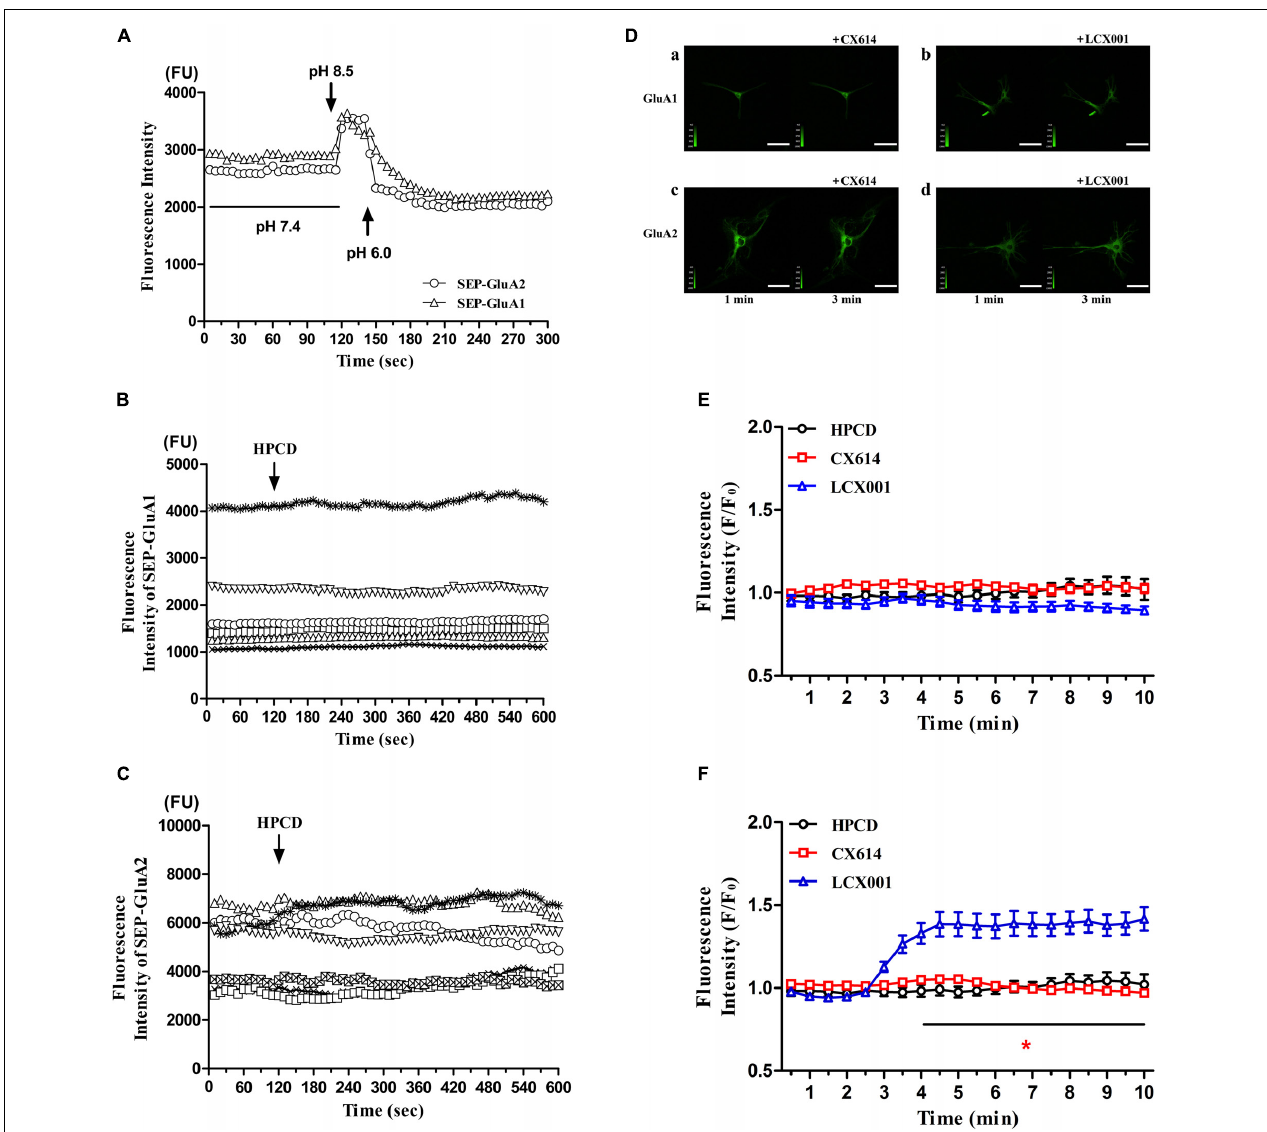
FIGURE 5 | LCX001 increased surface expression of GluA2-containing AMPARs. (A) Time courses of SEP-GluA1 and SEP-GluA2 fluorescence in primary medulla oblongata neurons after exposure to extracellular alkali or acidic solutions. (B,C) SEP-GluA1 or SEP-GluA2 fluorescence time course after vehicle (20% HPCD) treatment at the time point of 2 min. The application of vehicle control had no influence on fluorescence intensity, n = 6. (D) Representative live cell images from primary medulla oblongata neurons transfected with SEP-GluA1 or SEP-GluA2 in the presence of LCX001 or CX614 (final dose of 47 µ M). a. SEP-GluA1 treated with CX614 at 2 min, b. SEP-GluA1 treated with LCX001 at 2 min, c. SEP-GluA2 treated with CX614 at 2 min, d. SEP-GluA2 treated with LCX001 at 2 min. (E,F) Relative fluorescence intensity to the vehicle of pHluorin-GluA2 and GluA1 in response to LCX001 or CX614 treatment. Application of LCX001 at a final dose of 47 µ M resulted in a significant increase in SEP-GluA2 fluorescence and enhanced stabilization of surface GluA2-containing AMPARs. ∗ P < 0.05, two-way ANOVA followed by Bonferroni post-hoc tests, mean ± SEM, n =